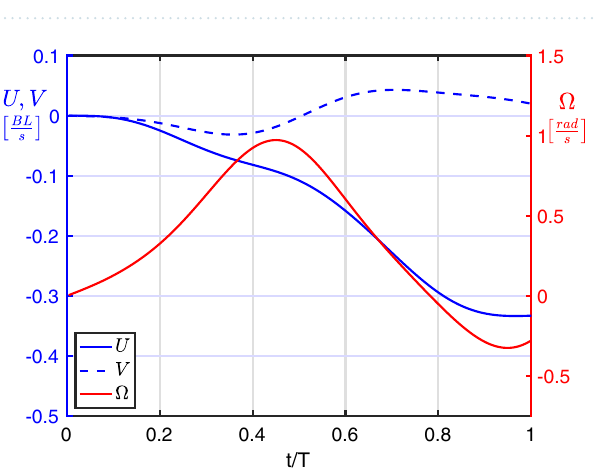
Figure 1. Snapshots of the C-start maneuver of a neutrally buoyant fish from the numerical simulation. The relative animation is reported in Movie S1.